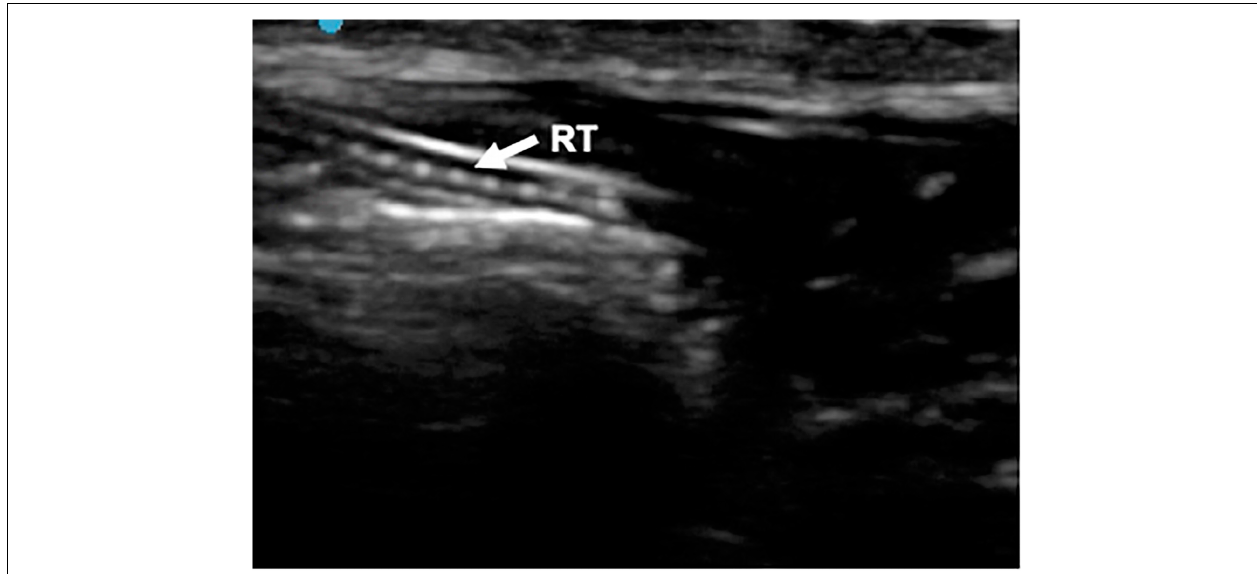
FIGURE 5 | Longitudinal anterior plane of the neck. RT, reinforced tracheal tub.